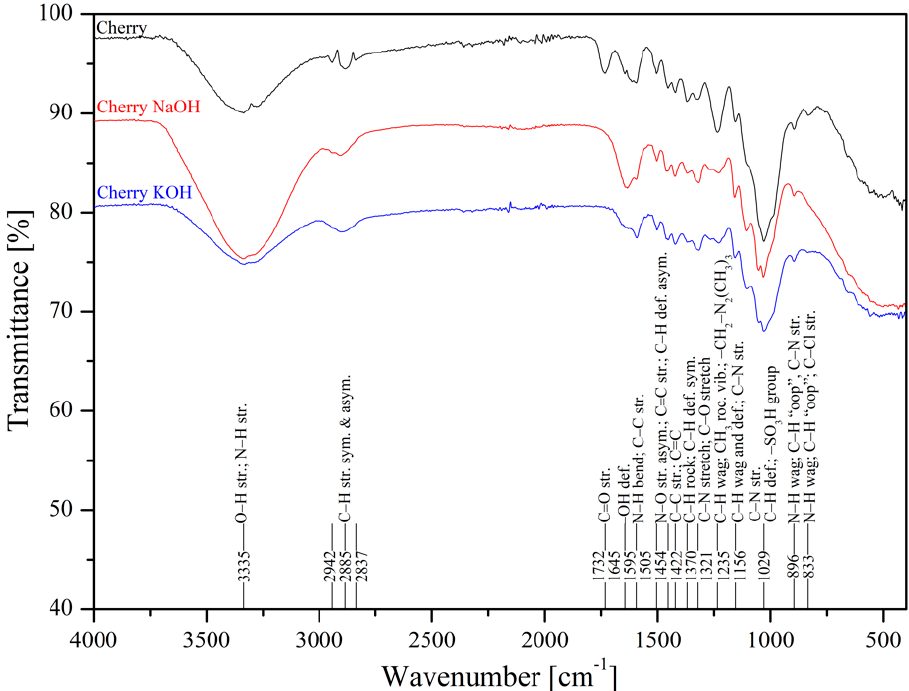
Figure 2. Infrared spectra of natural and treated cherry sawdusts.